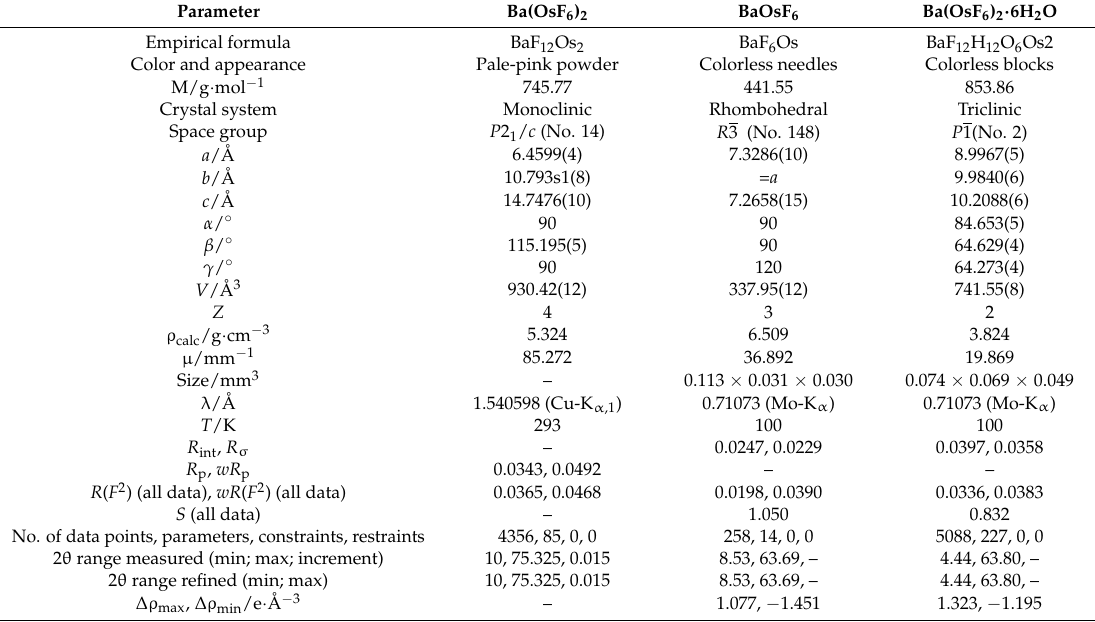
Table 2. Crystallographic details of the characterized